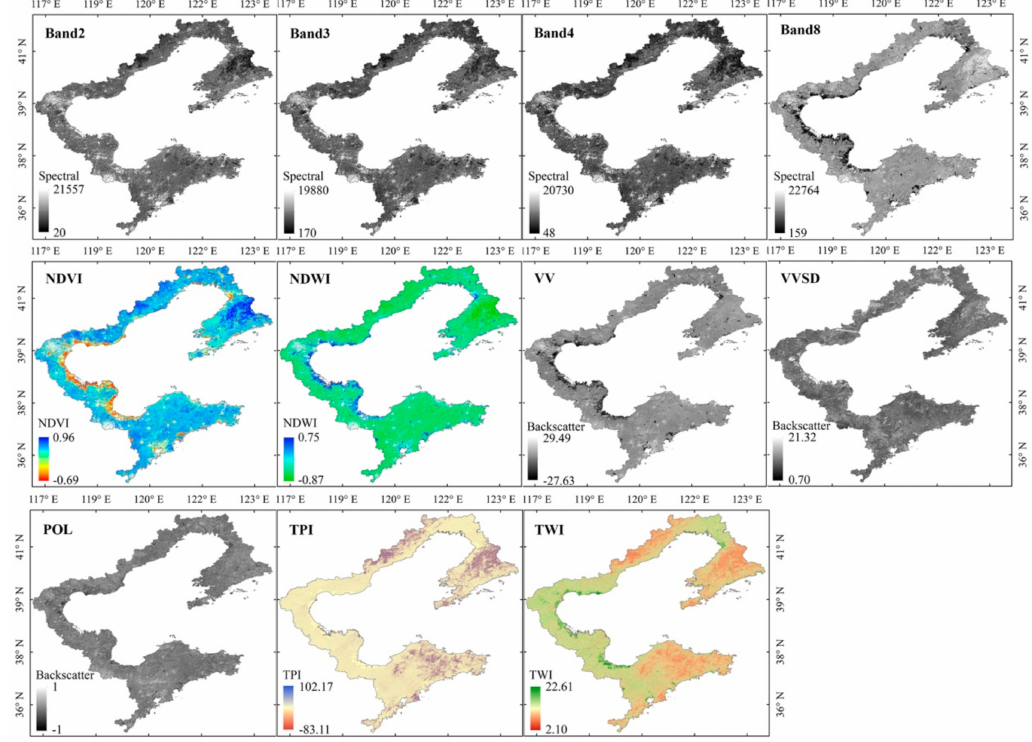
Figure 2. Spatial distributions of the input